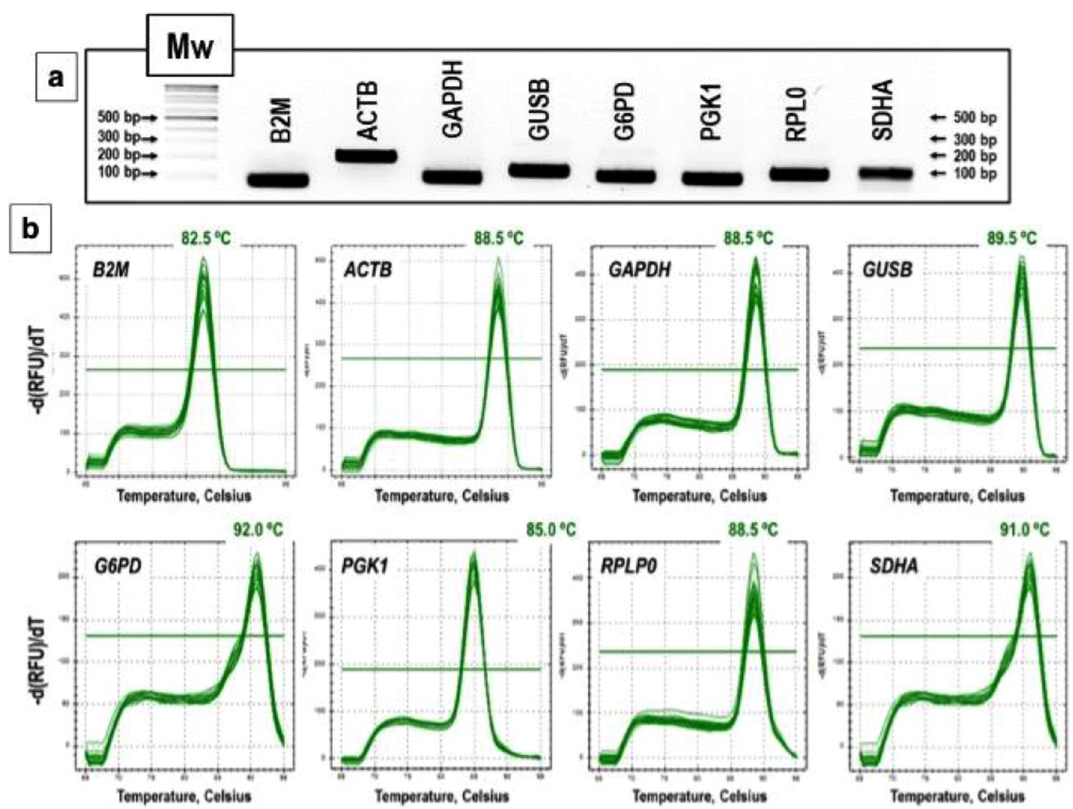
Figure 2. Gene specificity and amplicon size and Tm. ( a ) Agarose gel (2%) of qRT-PCR products for each gene showing one band of the expected size. Equal amounts of cDNA from each sample were mixed and